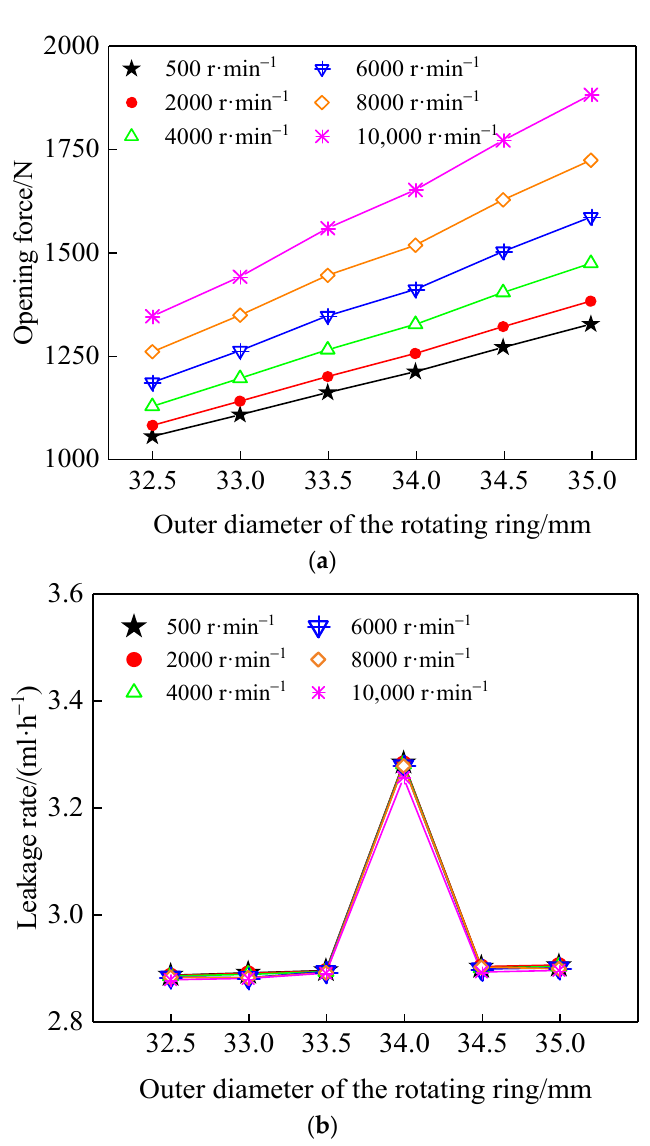
Figure 8. Influence of the diffuser groove length on its sealing performance: ( a ) Influence on the opening force; ( b ) Influence on the leakage rate. ( h k i = h g = 50 μ m, r o = 30.6 mm, N g = 22, γ = 0.5, λ = 0.9, α = 30°, Δ p = 0.5 MPa)